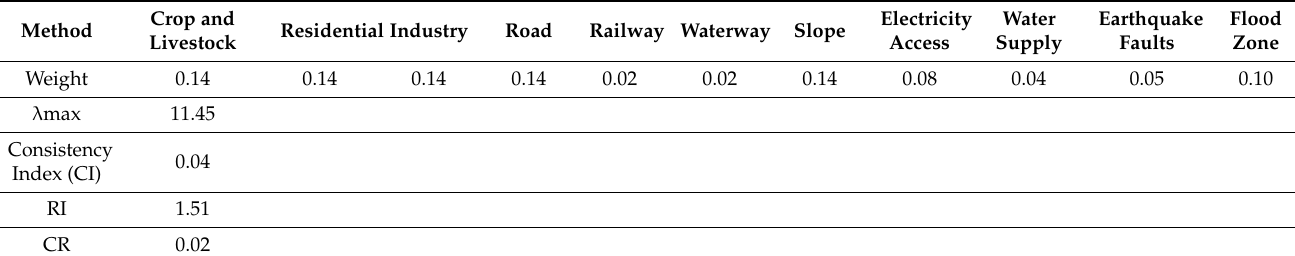
Figure 8. Factor variables for Weighted Overlay Map. Table 3. Evaluated Weight by AHP Method.